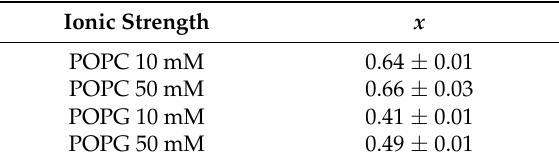
Table 1. The calculated orientation distribution of bR in POPC and POPG vesicles under different ionic strengths. (The value of x indicates the percentage of the TAMRA-bR with N-terminus pointing inside the vesicles).